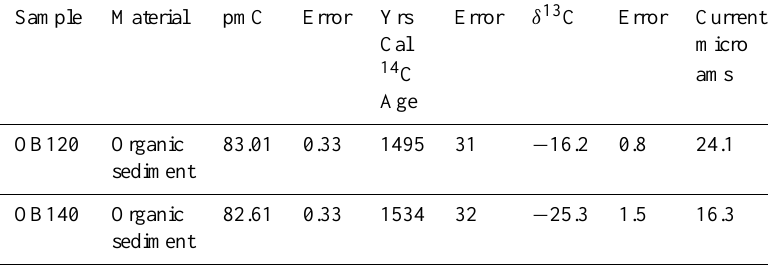
Table 2. Radiocarbon results from samples collected in core OB1 (120) and OB1